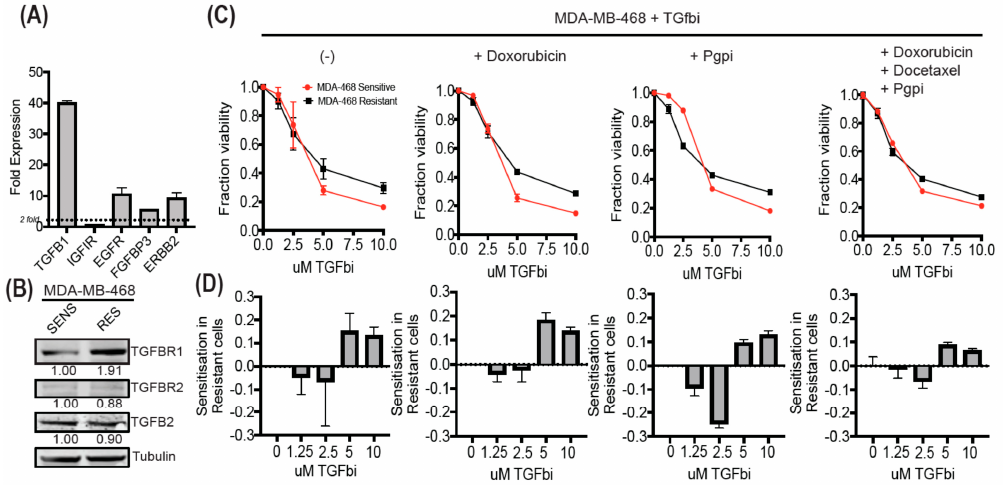
Figure 5. Low-dose targeting of TGF- β receptor 1 sensitizes chemoresistant MDA-MB-468. ( A ) Gene expression analysis of growth factor ligands and cell surface receptors in docetaxel / doxorubicin-adapted MDA-MB-468 (RES) cells as a ratio compared to matched sensitive MDA-MB-468 (SENS) cells. ( B ) Protein expression of TGF- β receptors (TGFBR1 / 2) and ligand (TGFB2) comparing matched MDA-MB-468-sensitive and -resistant cell lines. ( C ) TGF- β receptor 1 inhibitor SB525334 dose curves with the addition of doxorubicin, p-glycoprotein pump inhibitor (Pgpi), and the combination of doxorubicin (50 nM), docetaxel (0.5 nM), and Pgpi (1 µ M). ( D ) The change in the sensitivity of the resistant cell line compared to sensitive cell line under the conditions in ( C ). All experiments were performed in triplicate and plotted as average +/ -